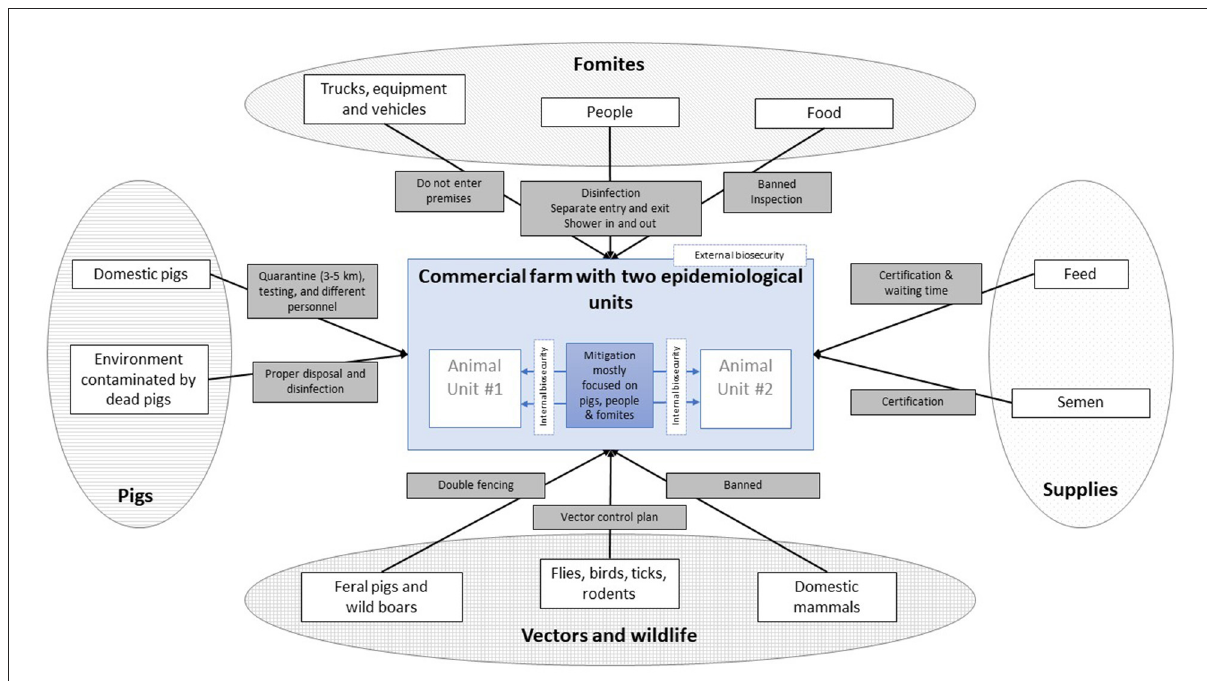
FIGURE1 Possible pathways (white boxes, n = 10) of introduction of African Swine Fever (ASF) into commercial pig farms, grouped by the primary source of infection (ovals, n = 4) and indicating proposed mitigation measures for each of them (gray boxes, n =